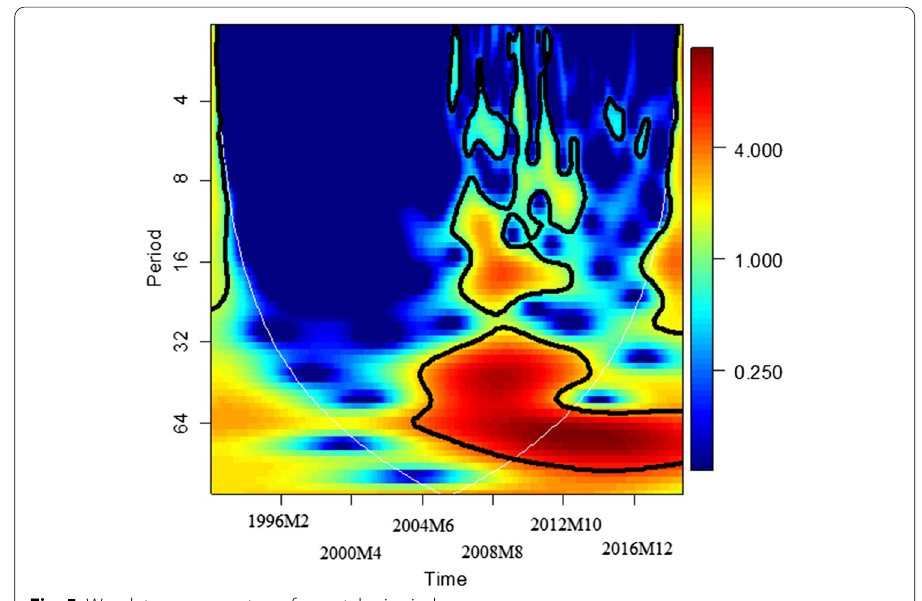
Fig. 5 Wavelet power spectrum for metal price index